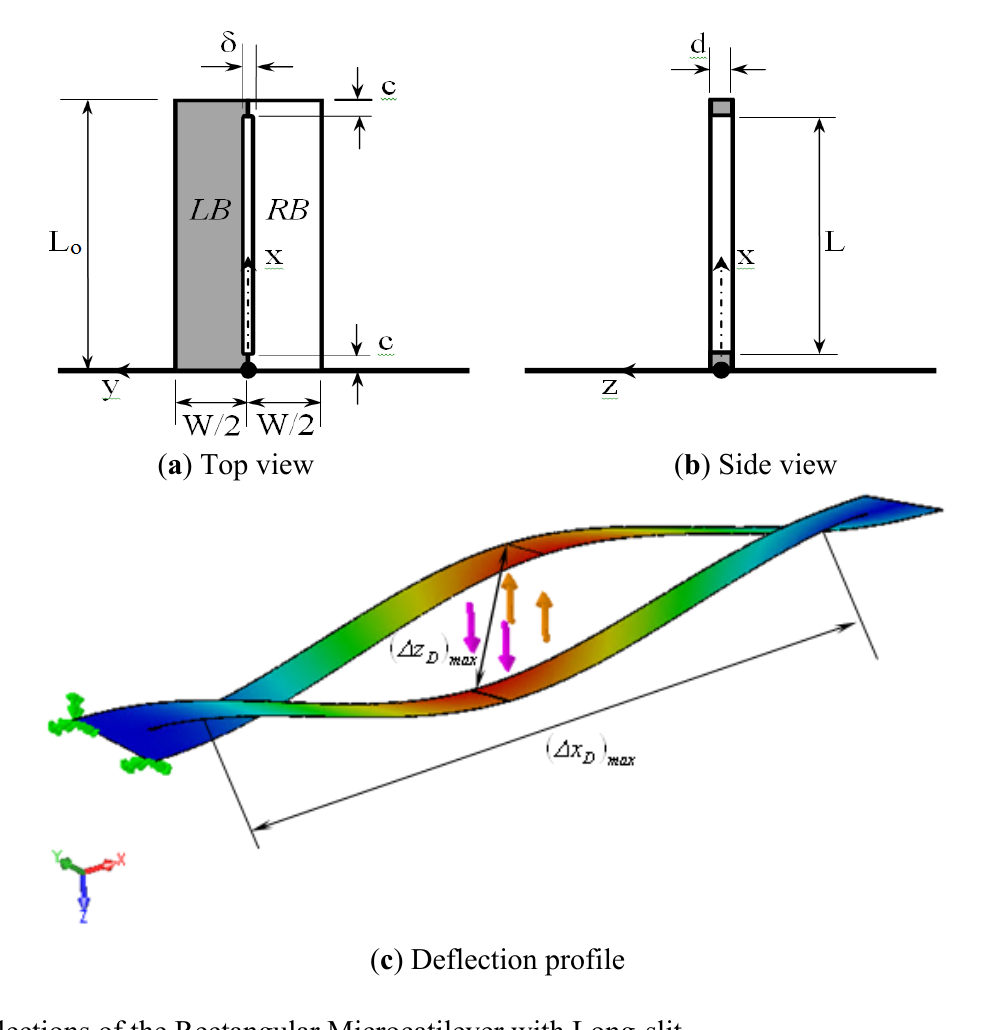
Figure 2. Schematic diagrams and the corresponding coordinate system for the rectangular microcantliever with long-slit: ( a ) Top view of rectangular MC with long-slit; ( b ) Side view of rectangular MC with long-slit, and ( c ) Deflection profile of rectangular MC with long- slit with major deflection